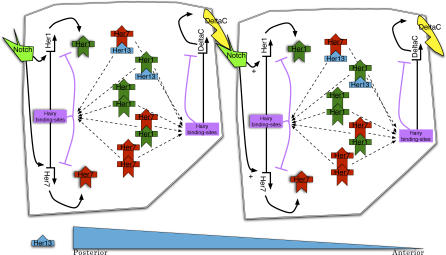
Model of the Interactions between Her Proteins in the Zebrafish Network Driving Somitogenesis OscillationsHer1, Her7, and Her13.2 (abbreviated to Her13) can form heterodimers, and Her1 and Her7 can also form homodimers. Each dimer species competes to set the level of repression of her1, her7, and deltaC to a specific level. (This is inspired by the experimental result that a combination of Her1 and Her13.2 leads to more potent repression than Her1 alone.) Intercellular communication occurs through DeltaC-Notch signaling, which enhances her1, her7, and deltaC transcription. her13.2 mRNA is expressed in a posterior–anterior gradient in the PSM.